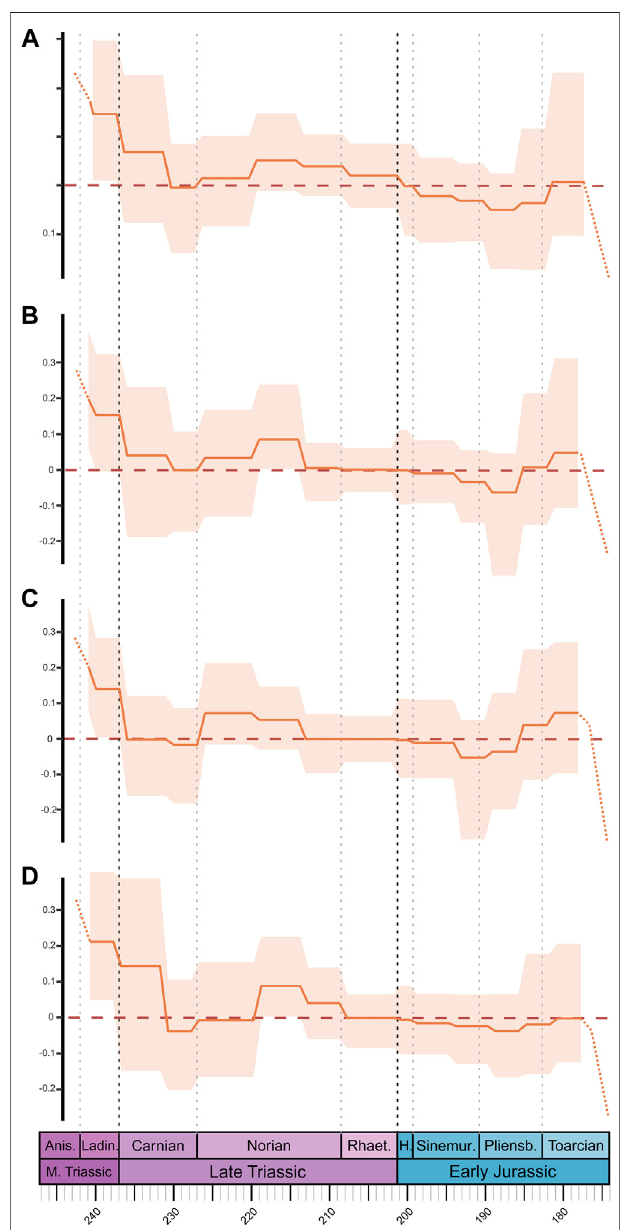
FIGURE 3 | Net diversi fi cation rates of Triassic to Early Jurassic terrestrial Pan-Aves, estimated from phylogenetic trees using the episodic fossilized-birth-death (EFBD) model from RevBayes. Solid orange line represents the mean values (posterior estimates) across all ten trees, whereas light orange shade represents 95% credible intervals. Dashed orangelinerepresentstheuncertaintyofpatternsthroughtheToarcian,froma possible “ edge effect. ” Results shown for the four topologies with “ ghost lineages ” and sampling parameter ( Φ 0)of0.08. Topologies (A) ST1, (B) ST2, (C) ST 3, and (D) ST 4. Timescale abbreviations: as in Figure 1 .